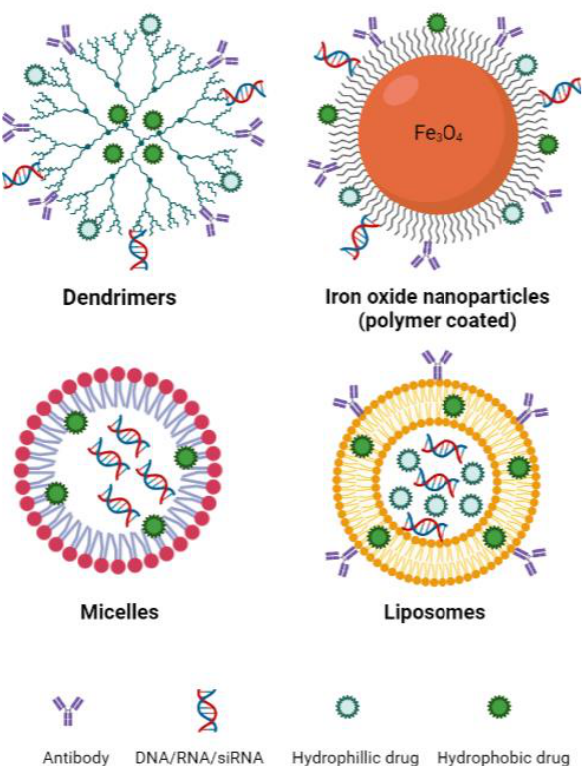
Figure 3. Basic structure of common nanotechnologies used to induce ferroptosis. Sizes: dendrimers 1–10 nm [141], iron oxide nanoparticles 10–20 nm [142], micelles 10–100 nm [143], liposomes 30 nm